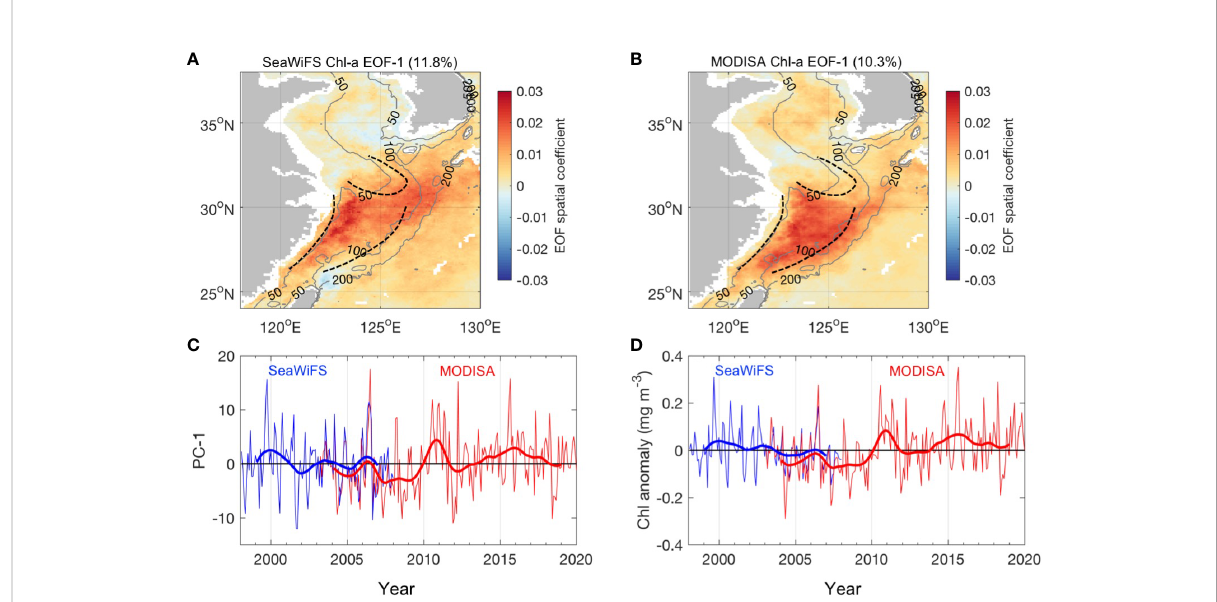
FIGURE 5 EOF analysis of Chl -a anomalies. (A, B) The spatial coef fi cient of the fi rst EOF mode for the SeaWiFS and MODISA Chl -a anomalies, respectively; the black dashed contours indicate the position of the fronts referred from Belkin et al. (2009) and Liu et al. (2018). The gray contour lines in each map denote the 50-, 100-, and 200-m isobaths. (C) The EOF temporal amplitude (PC) for SeaWiFS (blue) and MODISA (red) Chl -a . The thick blue and red lines denote the 12-month low-pass- fi ltered PC-1. (D) Time series of Chl -a anomalies averaged for the area in the mid-shelf of ECS where the EOF eigenvectors are larger than